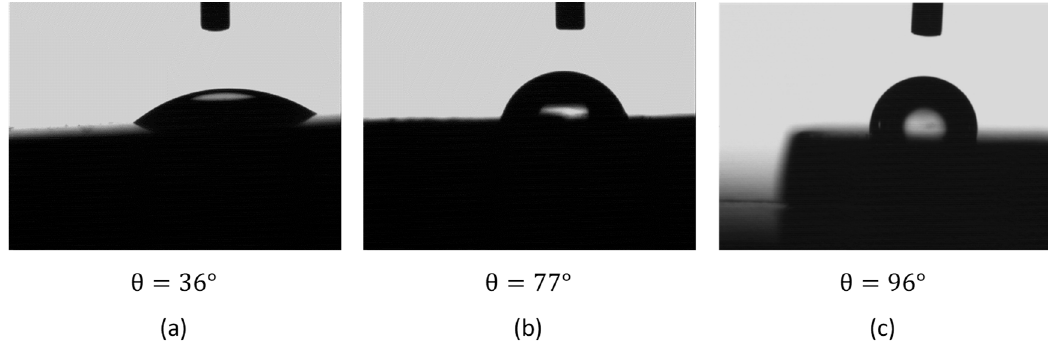
Figure 5. Static sessile drop technique images and contact angles θ ( a ) no film-forming amines (FFA) coating, ( b ) FFA coating: 5 ppm, 1 day, 60 °C, ( c ) FFA coating: 5 ppm, 1 day, 90 °C. Influence of FFA coating application temperature on hydrophobicity of NiCrMoV steel.